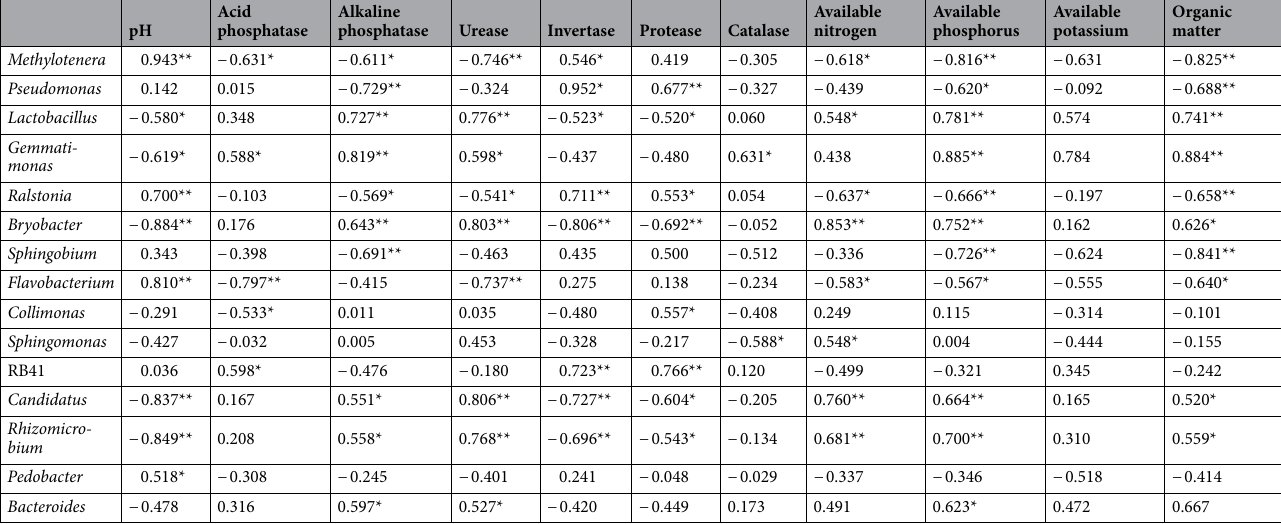
Table 6. Correlation analysis of the bio-chemical factors and the dominant genera in the rhizospheric soil of F. taipaiensis with different cultivation years. * p < 0.05, ** p <